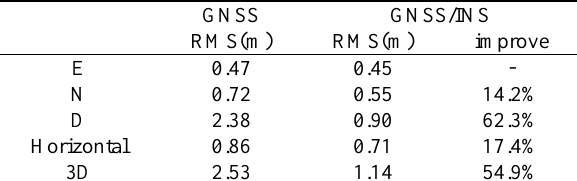
Figure 6 . Attitude angle error of GNSS/INS tightly-coupled Table 3. Position error in END direction